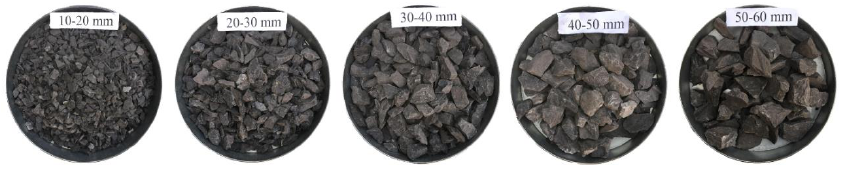
Figure 1. The preparation of samples.